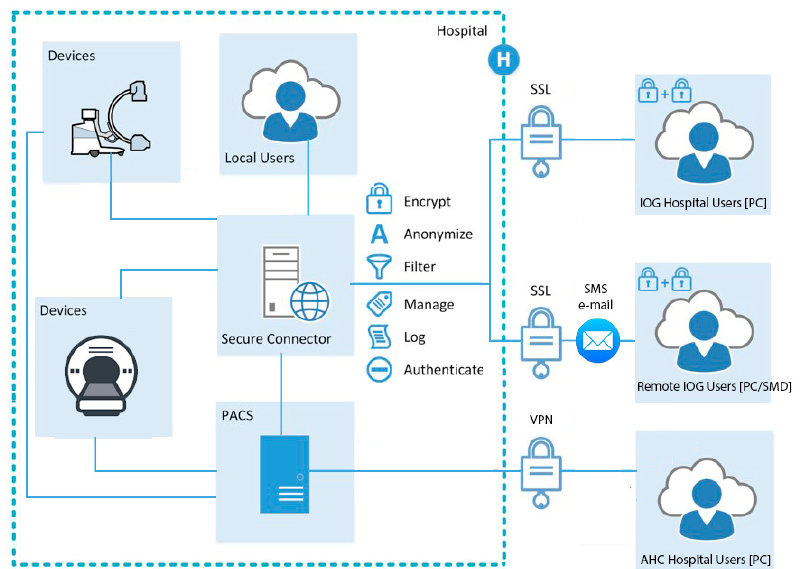
Figure 2. Principles for AHC and IOG accessing PACS from outside the hospital network while staying compliant with applicable patient data regulations. The AHC uses a predefined user account and a VPN solution to enable access to the secure hospital network while IOG uses two step authentication and a preinstalled connector which acts as a relay between the user and the hospital network. This connector also enables invited users to view anonymized image data via a link provided by a user.